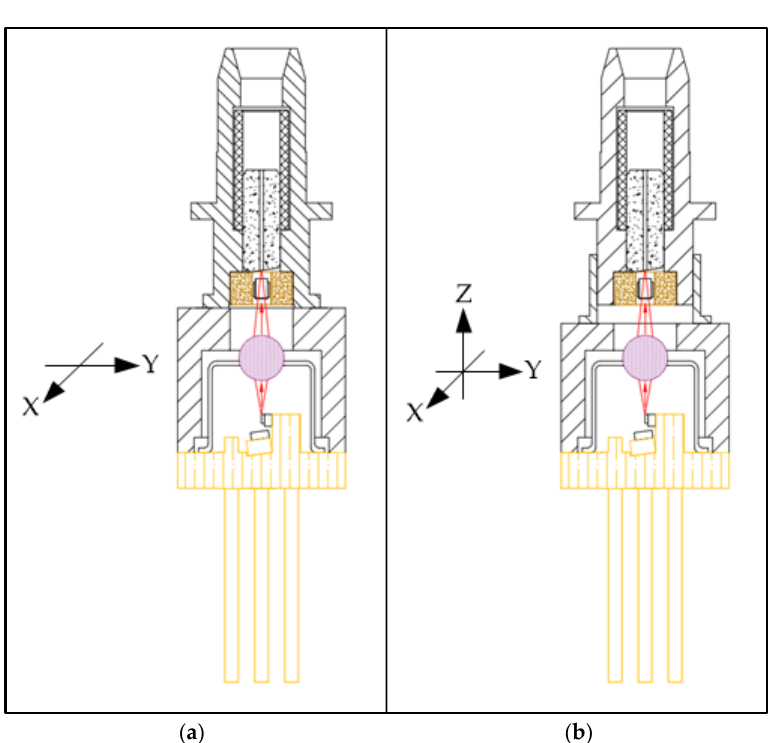
Figure 3. Coupling model of TOSA. ( a ) 2D coupling model; ( b ) 3D coupling model.